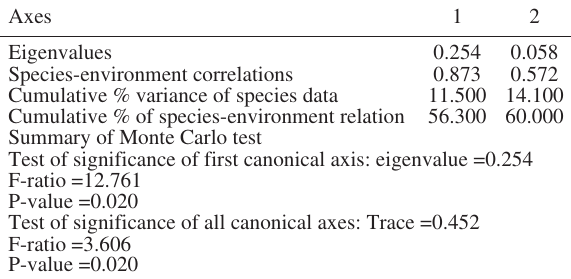
Table 3. – Results of the canonical correspondence analysis applied to the species and environmental variables. The Monte Carlo test was used for significance of the canonical axes.